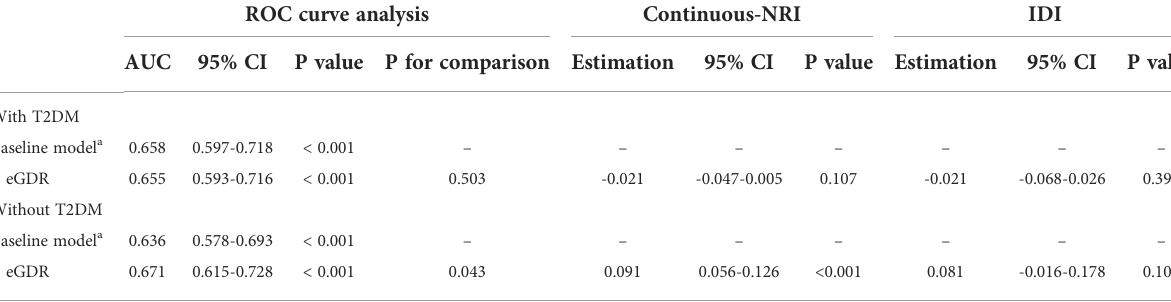
TABLE 4 Incremental effect of eGDR on ISR prediction by existing risk model in populations with and without T2DM. ROC curve